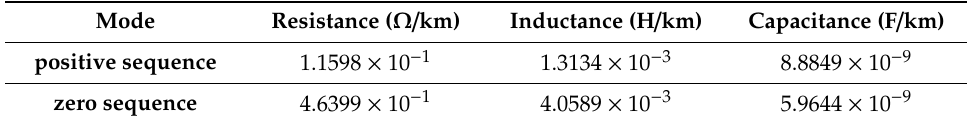
Table 10. Parameters of transmission lines.